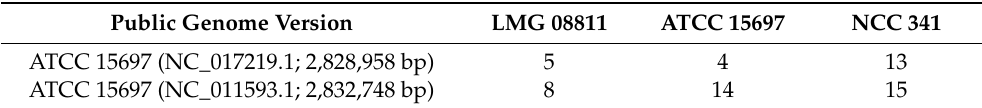
Table 1. Genomic SNP level comparison of different isolates of the B. infantis ATCC 15697 (type strain) sourced from different culture collection. All three isolates were compared to the two publicly available genomes of the strain. Genome accession numbers and sizes are indicated in parentheses.